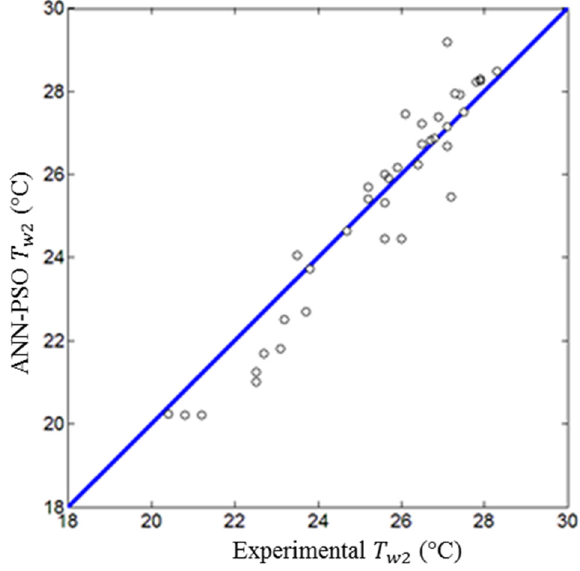
Figure 15. Estimated outlet water temperature by ANN ‐ PSO based on experimental data (test stage).